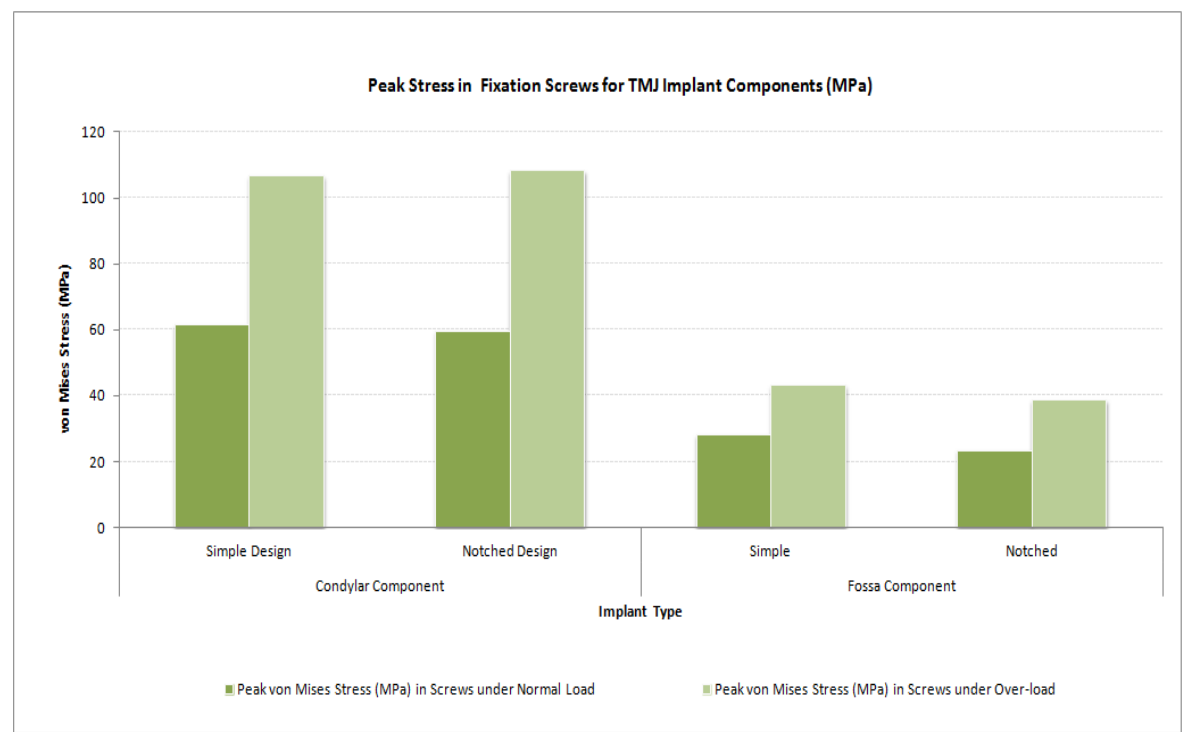
Figure 36. Peak von Mises stress in the fixation screws for condylar/ramus and fossa components of patient-specific total TMJ prostheses during FE simulations under normal and worst-case/over-load configurations.